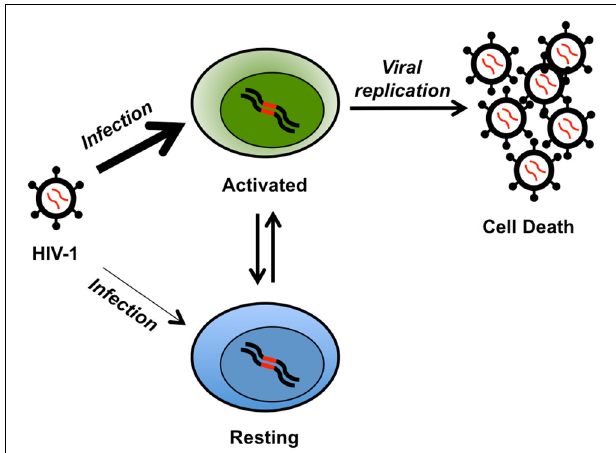
FIGURE 1 | Cartoon of latent reservoir formation. The HIV-1 virus readily infects (thick arrow) activated CD4 + T cells (green, integrated provirus in red). HIV-1 replication in activated T cells typically leads to cell death. However, a fraction of these cells may become resting memory T cells (blue) and part of the latent reservoir. A perhaps less frequent (thin arrow) alternative mechanism for latency is the infection of resting naïve CD4 + T cells (blue). The latently infected resting naive or memory CD4 + T cells may become activated, leading to viral replication and cell